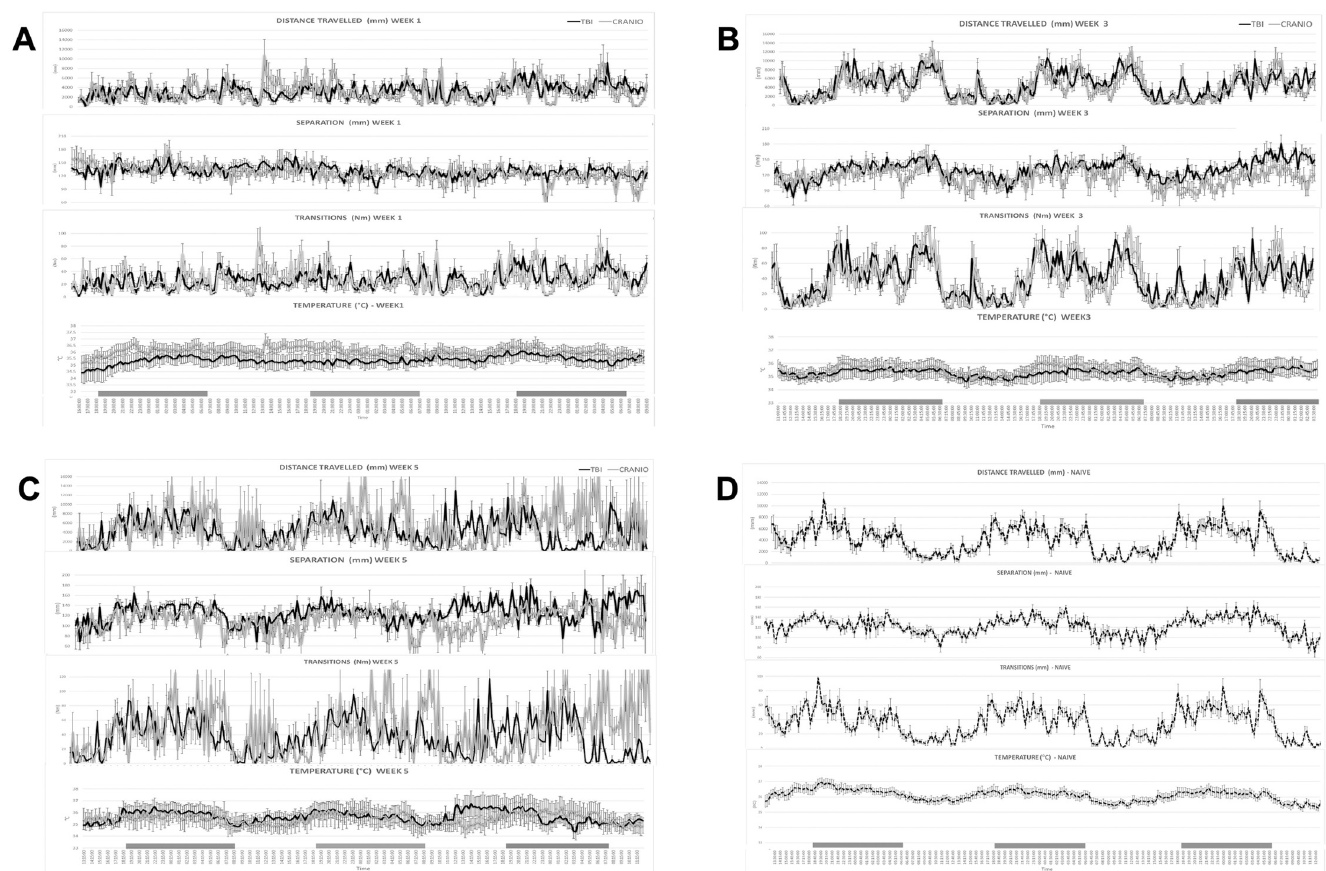
Fig 2. Representative graphs showing the data acquired from the Home Cage Analyser (ActualHCA ™ ) system, for the TBI-Injured, Sham-craniotomy and Naive animals. Parameters analysed include the distance travelled per animal (mm), number of transitions –as spatial transitions between the different RFID sensors, the distance between animals grouped housed in the same cage (mm) and the body temperature between individual animal ( º C). Data is shown as average ± SEM from the grouped animals per cage, plotted from the individual RFID recordings from each animal. Fig 2A–2C show data for the TBI-Injured and the sham-craniotomy groups, recorded during Week 1, Week 3 and Week 5 post-intervention, respectively. Fig 2D shows the recordings acquired for Naive animals, as a one-week baseline reference. Data shown covers a larger study cohort of 35 animals, including n = 16 as naive, n = 11 for the TBI group and n = 8 for the craniotomy group, including the cohorts used deep-learning modelling, as part of a larger ongoing recording project. All raw data used for ML analysis is provided as S1 File.